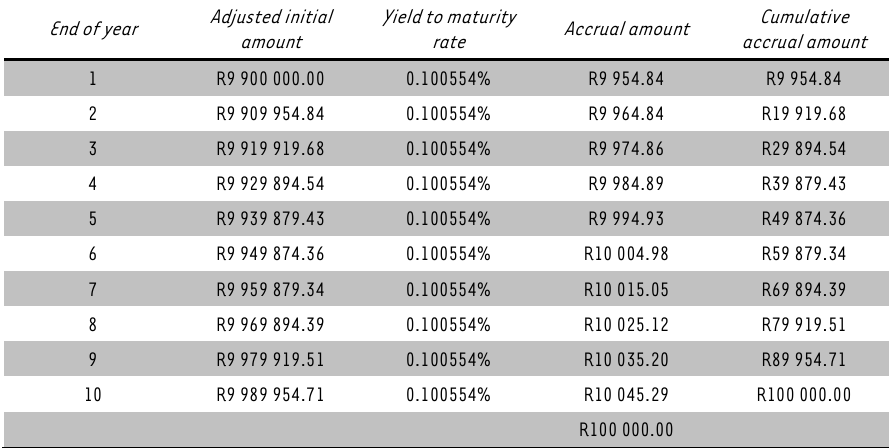
TABLE 2: Calculation of the adjusted initial amount as well as the accrual amount for years